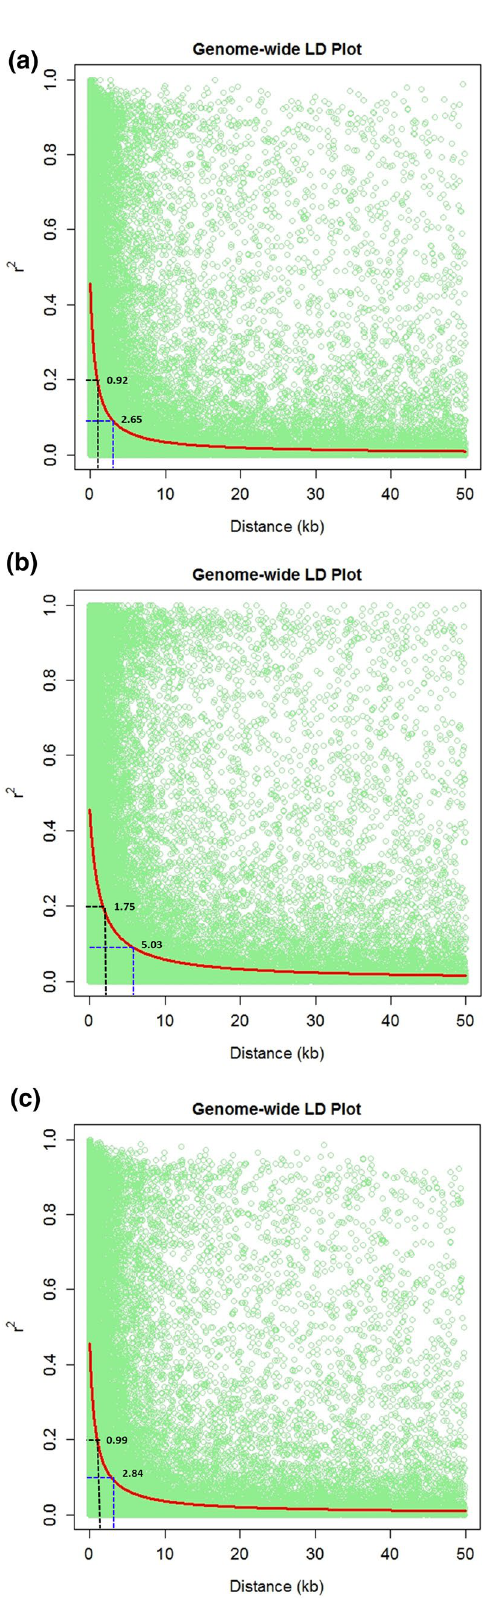
Figure 3. Linkage disequilibrium (LD) plot illustrating the average genome wide LD decay of ( a ) CAAM ( b ) DTMA and ( c ) IMAS panel using the SNPs with call rate 0.9 and minor allele frequency 0.1. The values on the Y-axis represents the squared correlation coefficient r 2 and the X-axis represents the genetic distance in kilo bases